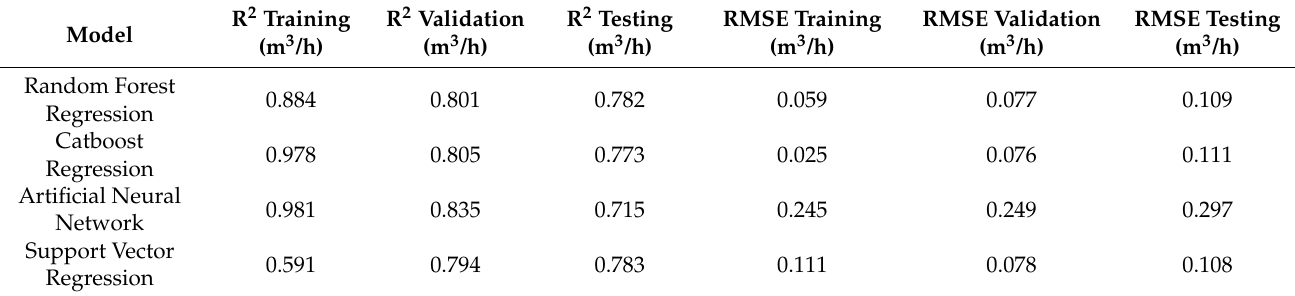
Table 4. Prediction accuracy result of different Machine Learning Models.